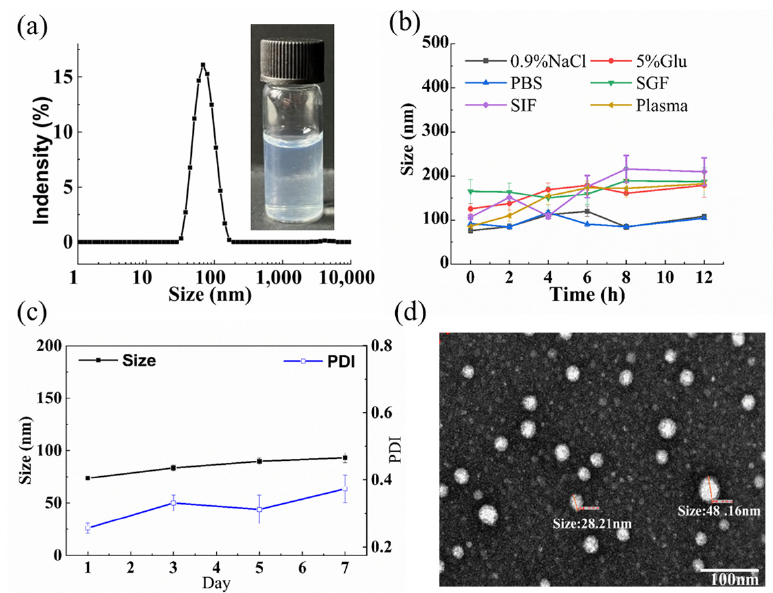
Figure 5. The actual photo and the particle size distribution of TH-NPs ( a ). The particle size and PDI change of TH-NPs in various physiological media ( b ). The particle size and PDI change of TH-NPs during the seven days shelf storage ( c ). Transmission electron microscopy image of TH-NPs ( d